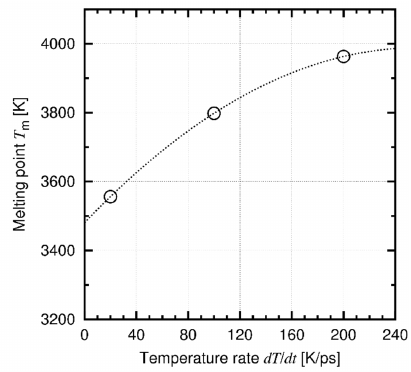
Figure A2. Melting temperature as a function of heating rate. The dashed curve indicates a quadratic approximation.